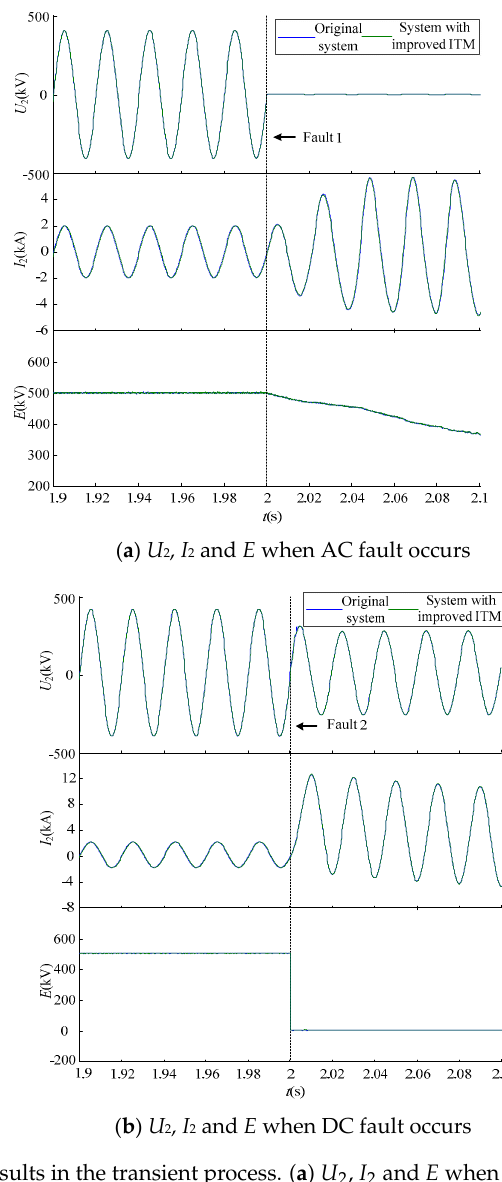
Figure 11. Simulation results in the transient process. ( a ) U 2 , I 2 and E when AC fault occurs. ( b ) U 2 , I 2 and E when DC fault